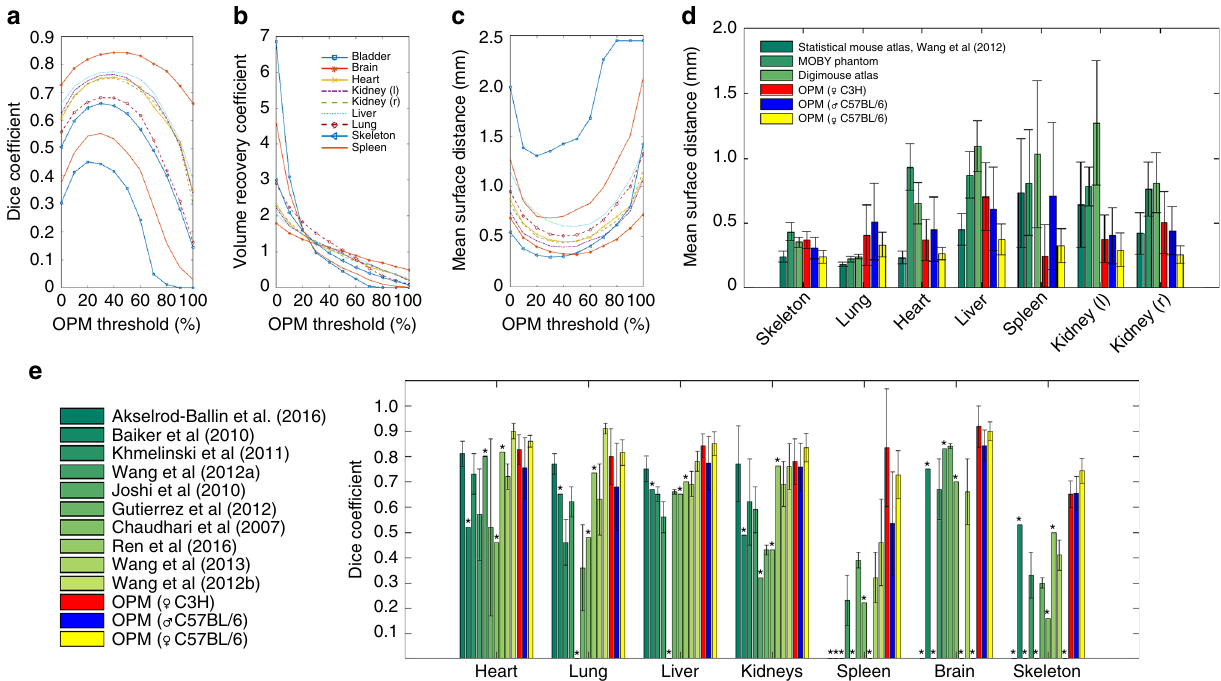
Fig. 5 Validation of BCAM and OPM. The anatomical registration accuracy of the female C3H, male C57BL/6, and female C57BL/6 OPMs has been validated for major organs using different registration metrics. a Dice coef fi cient, b volume recovery coef fi cient (VRC), and c mean surface distance (MSD) of male C57BL/6 mice for different probability thresholds using an expert data set of segmented CT scans ( n = 10). d MSD of OPMs (40% probability threshold) compared to results obtained by Wang et al. 42 . e Dice coef fi cients of OPMs (40% probability threshold) in comparison to different anatomical registration studies. These methods include: a multi-atlas registration for BLt (Ren et al. 2016 48 ); deformable mouse atlas registration (Gutierrez et al. 2012 47 ; Joshi et al. 2010 34 ; Chaudhari et al. 2007 21 ); multimodal organ segmentation and registration to BLi (Akselrod-Ballin et al. 2016 45 ); statistical mouse atlas registration (Wang et al. 2012(a) 36 , Wang et al. 2012(b) 42 , and Wang et al. 2013 44 ); automated organ segmentationusing atlas-based registration (Baiker et al. 2010 37 ); and articulated atlas registration for BLi (Khmelinskii et al. 2011 46 ). * No data